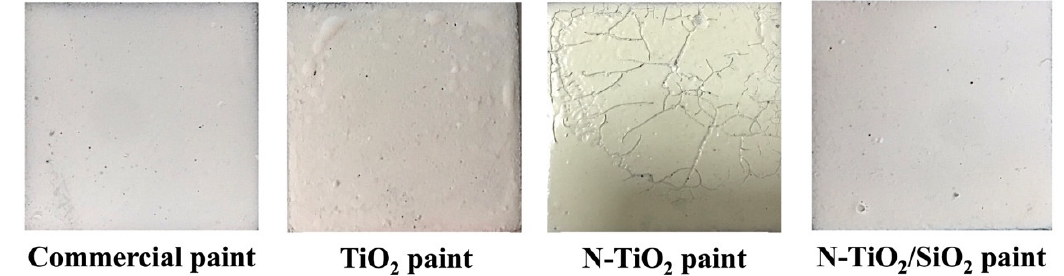
Figure 6. The acid resistance tests of commercial paint (without photocatalyst), TiO 2 paint, N-TiO 2 paint, and N-TiO 2 @SiO 2 paint .